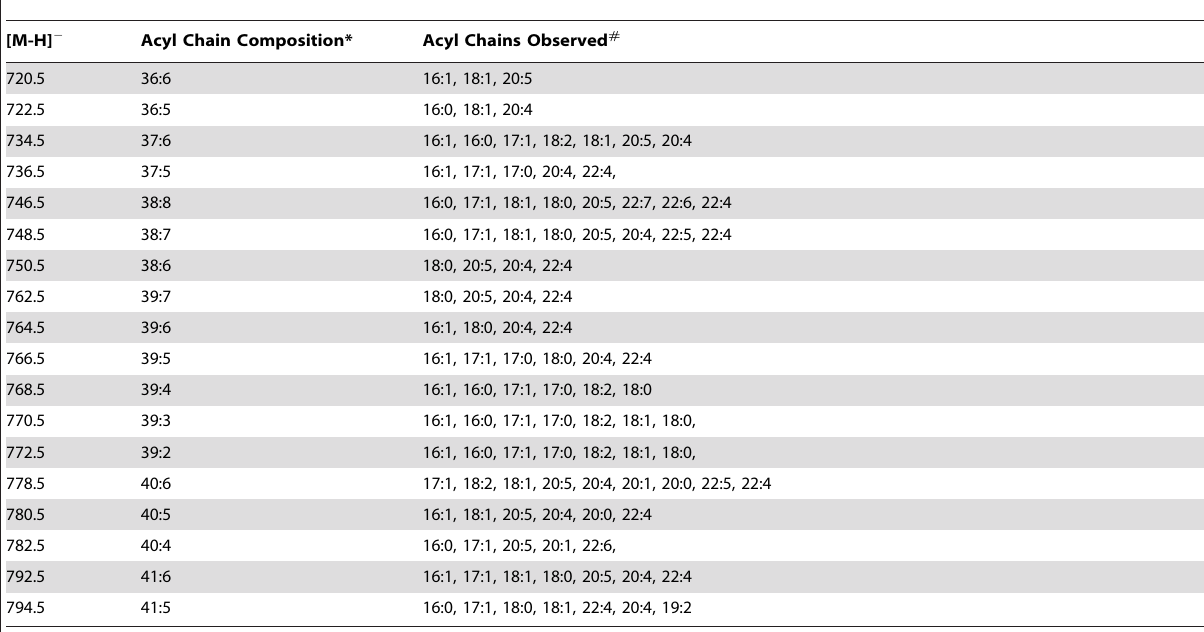
Table 3. Plasmalogen phosphatidylethanolamine species identified in A. pallida lipid extracts.